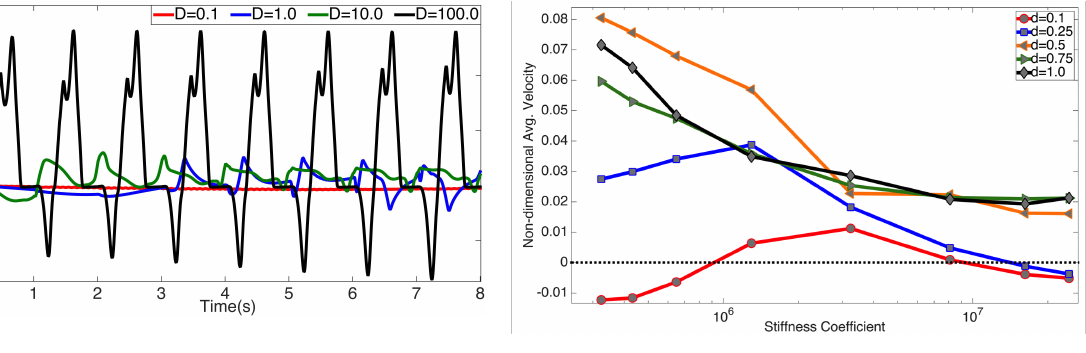
Fig. 12: A plot of non-dimensional spatially- averaged velocity computed across a cross- section at the top of the racetrack vs the non- dimensional stretching and bending stiffness co- efficients for pumping in the ‘dynamic suction pumping’ regime, for a variety of diffusivities,